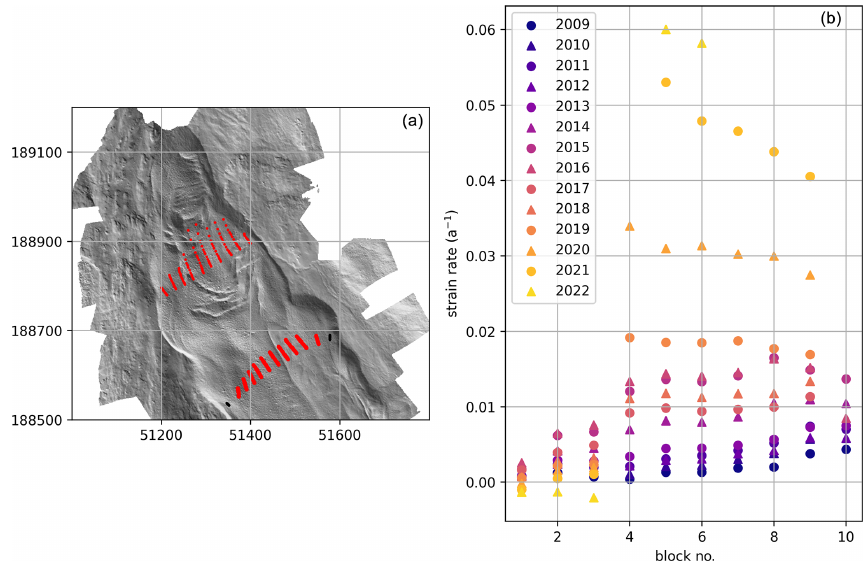
Figure 12. Strain rates for the blocks in P1 and P2 (excluding the furthest left and furthest right blocks in P2) for the measurement years 2009–2010 to 2021–2022. Panel (a) shows the location of the blocks in each year (red dots) over the 2021 hillshade. Panel (b) shows the strain rate per block pair, counting the blocks in the profile lines from west to